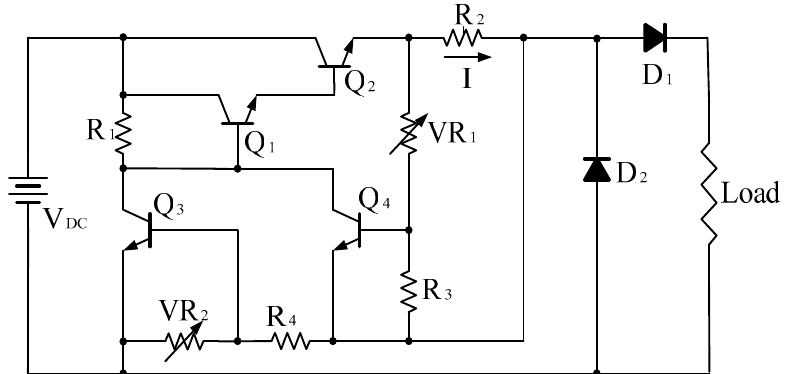
Figure 10. Circuit of the PV module simulator with adjustable settings for shading and failure.